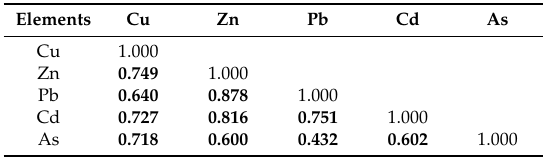
Table 2. Correlation coefficient ( r ) of trace elements in soils ( n =